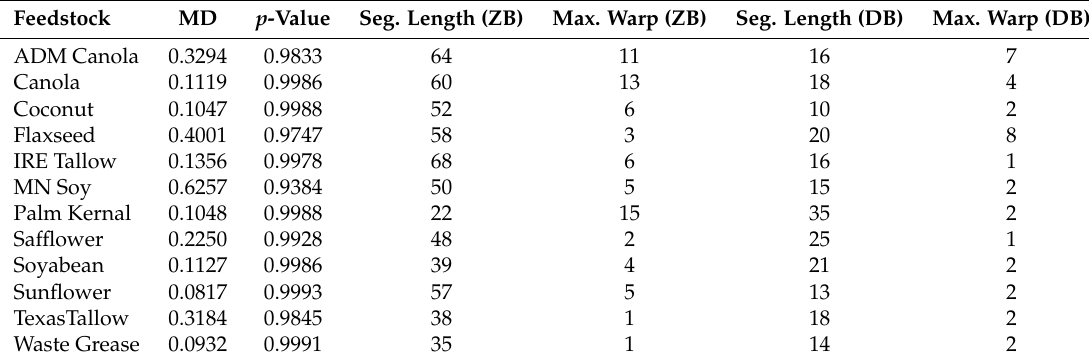
Table 3. MD, p -value, and optimal COW alignment parameters (segment length and maximum warp) for each feedstock, with alignment to a universal chromatogram chosen based on similarity index. The MD was computed based on L = 5